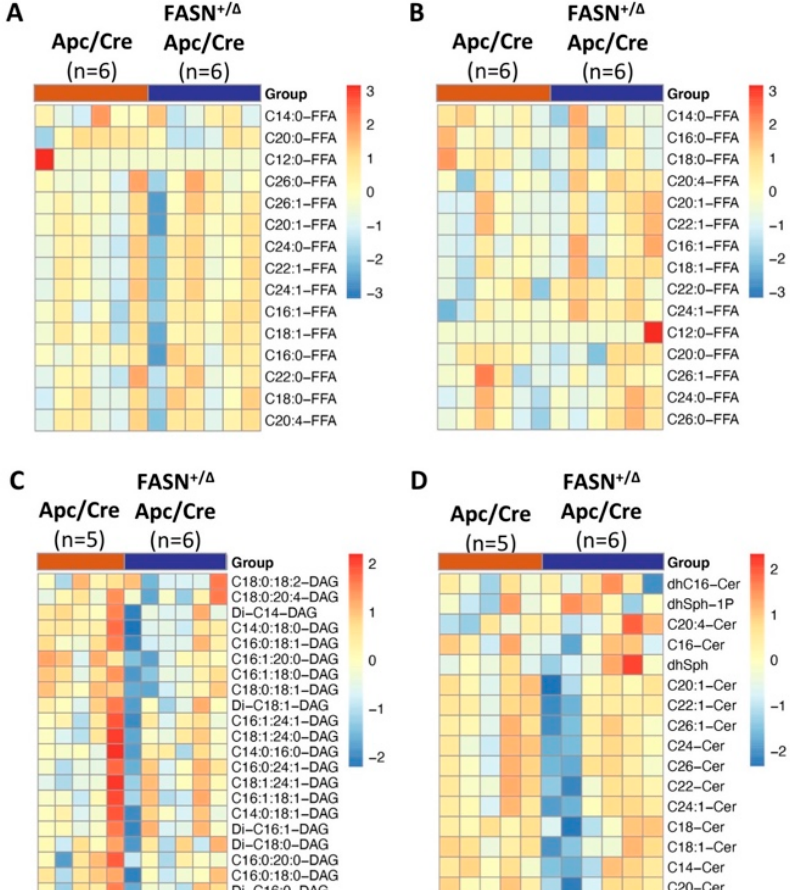
Figure 3. The effect of heterozygous deletion of FASN on lipid composition. Heat maps showing the composition of free fatty acids in ( A ) adenoma tissues and ( B ) plasma, and the composition of ( C ) diglycerides and ( D ) sphingolipids in mouse adenomas from Apc/Cre and FASN +/ ∆ Apc/Cre mice.